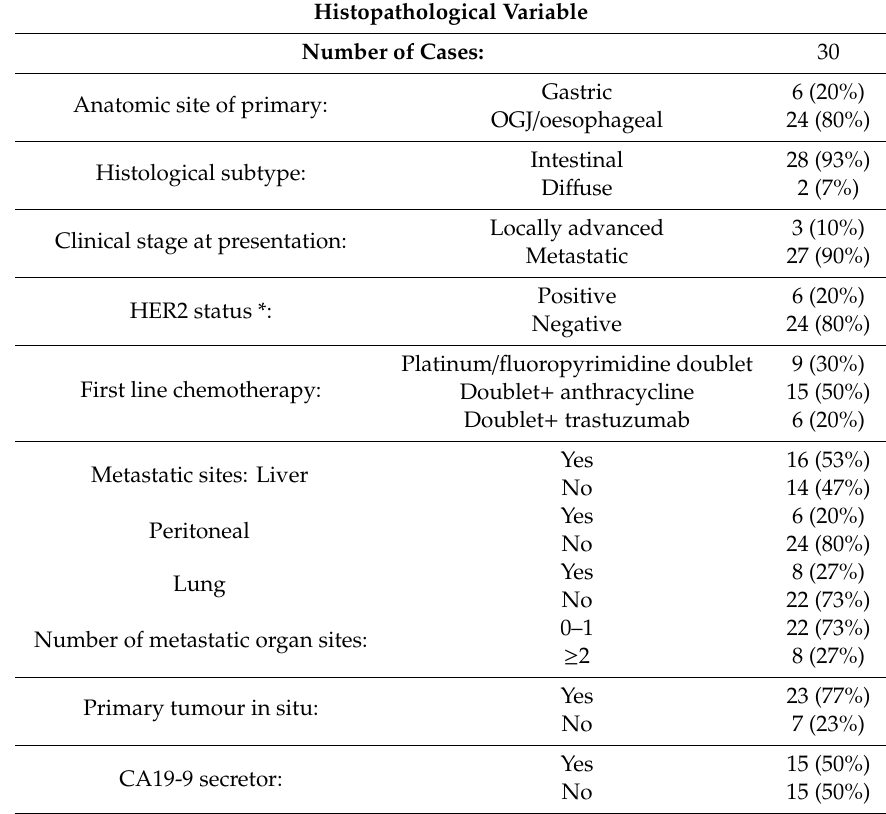
Table 1. Clinical characteristics of included